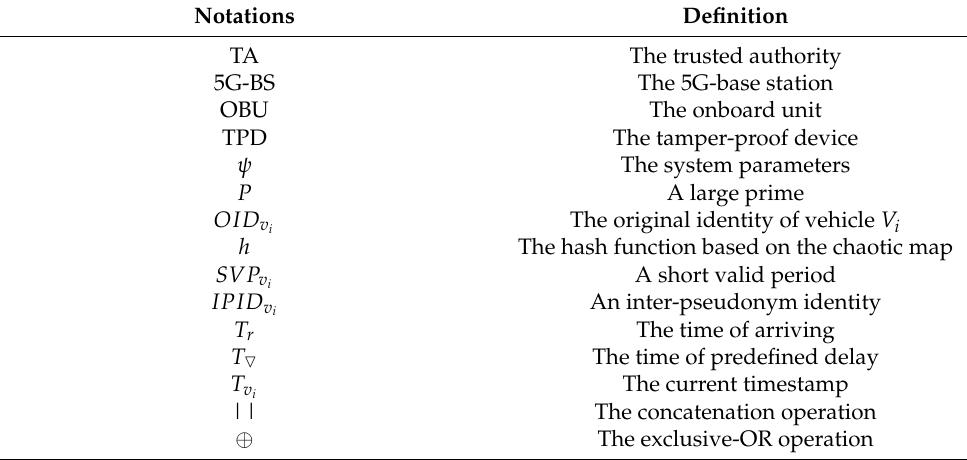
Table 1. Notations and Definitions